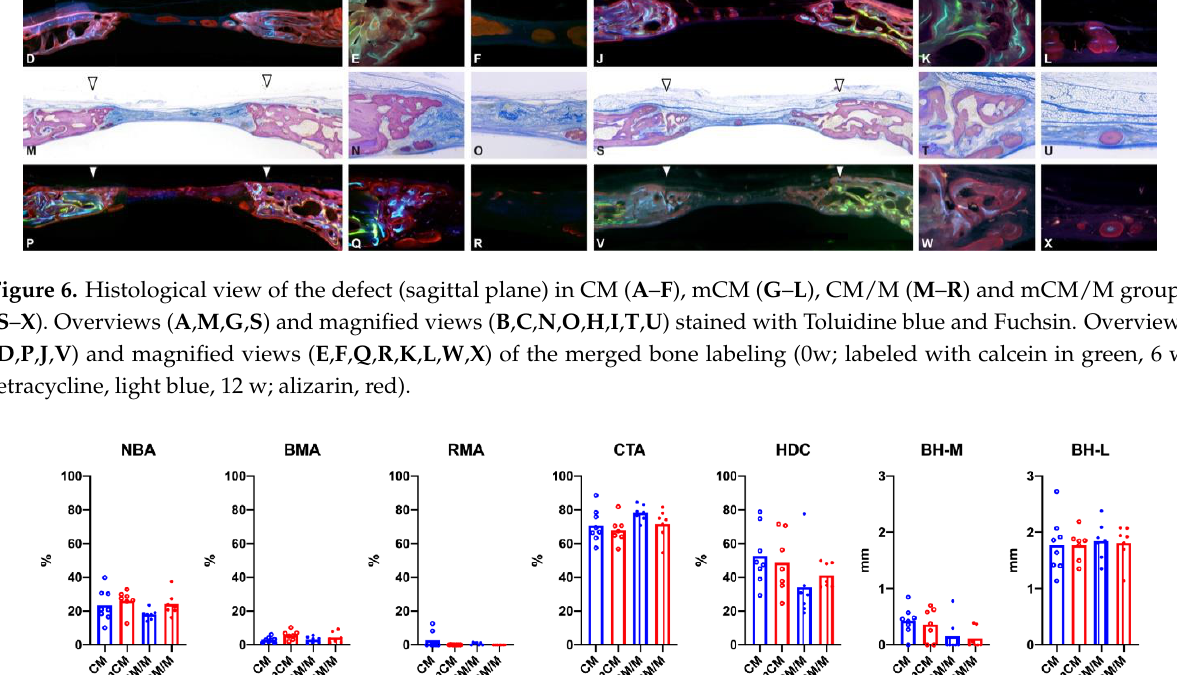
No significant differences were observed among the